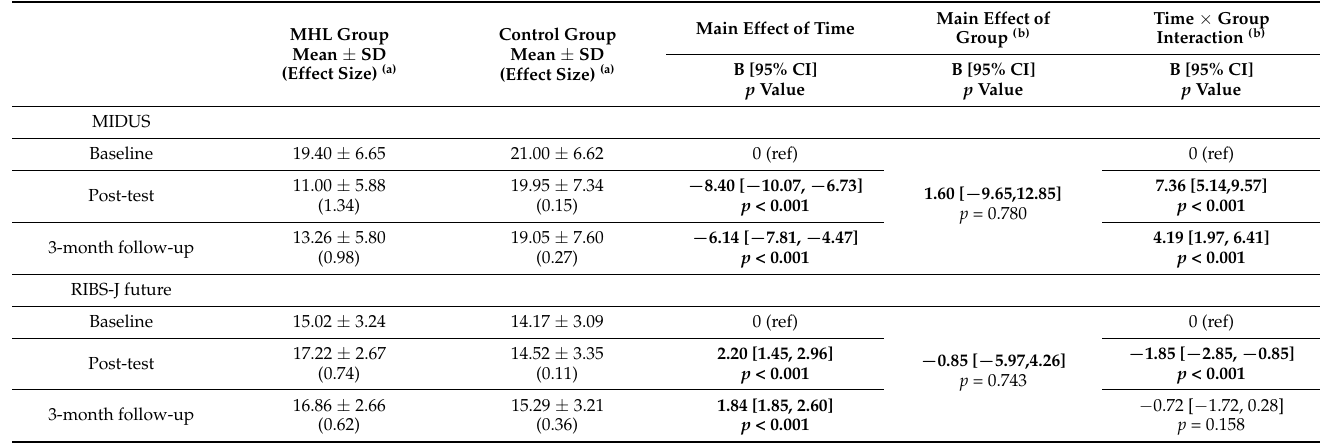
Table 3. Effects of MHL group and control group on MIDUS and RIBS-J future scores.